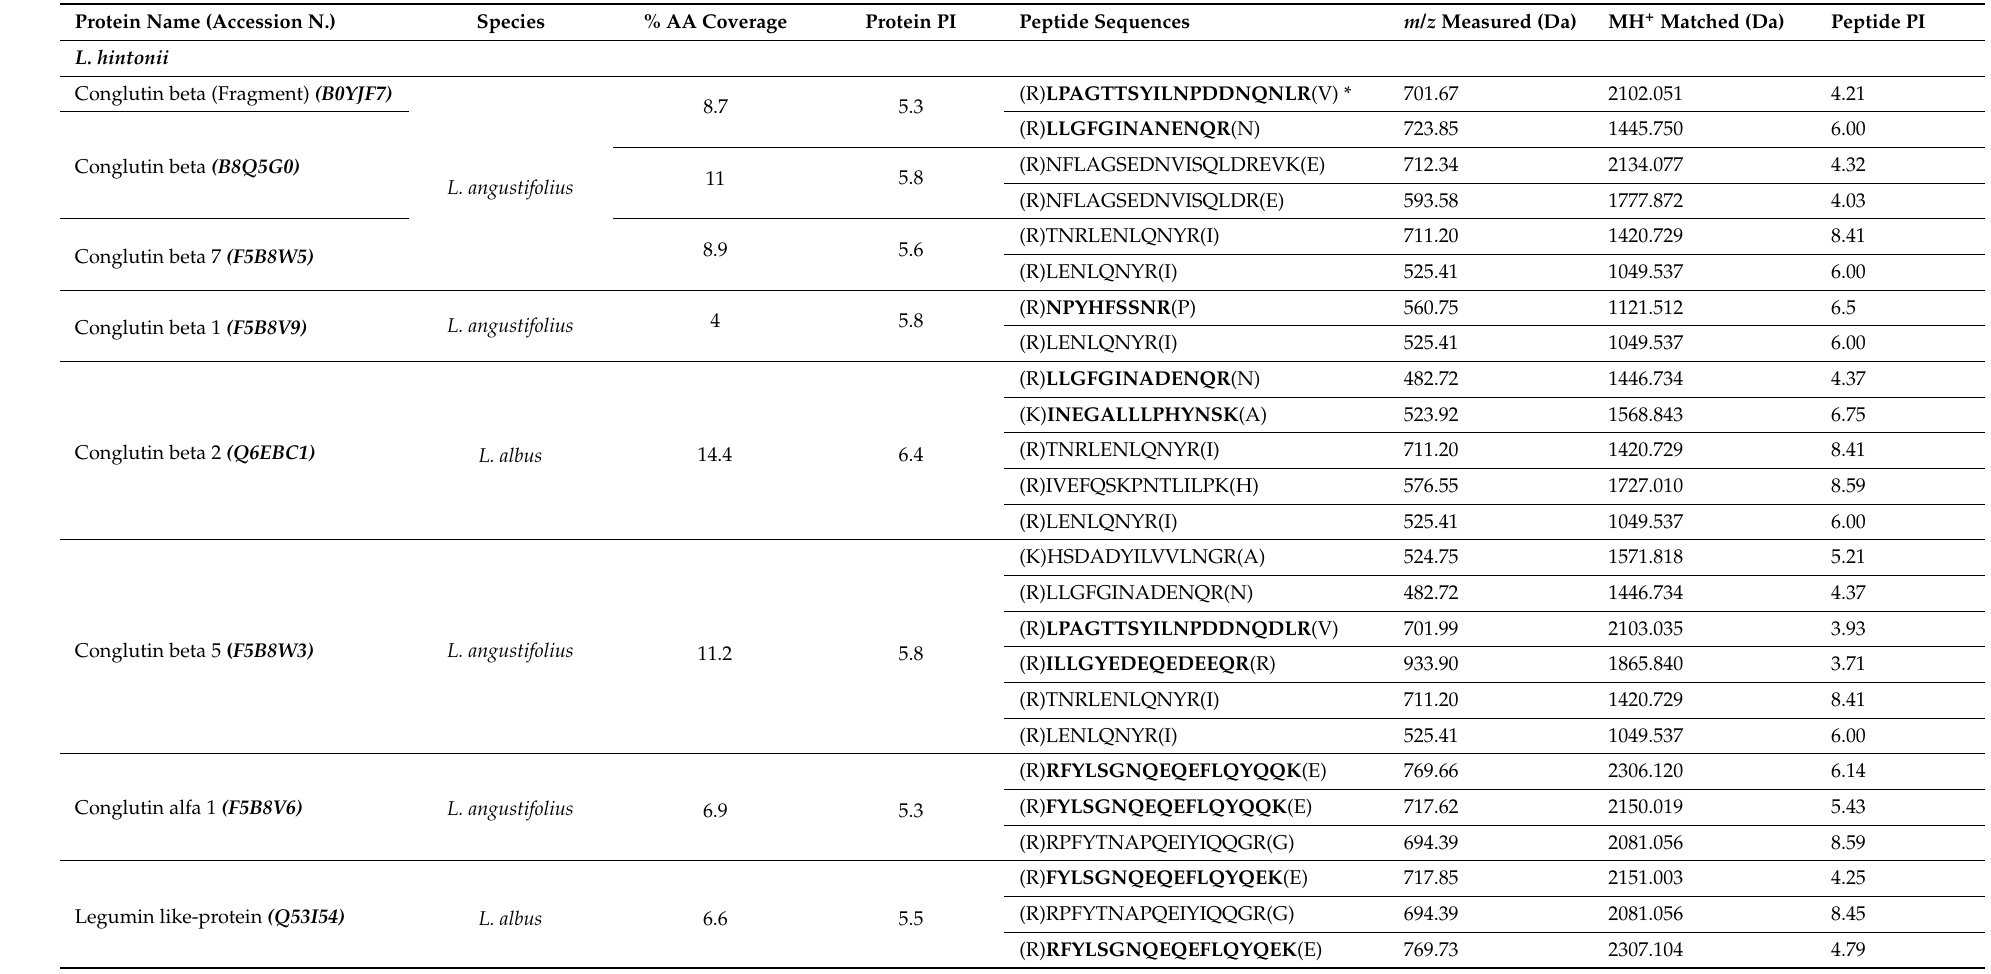
Table 1. Identified storage proteins in the seeds of the four wild lupin species by